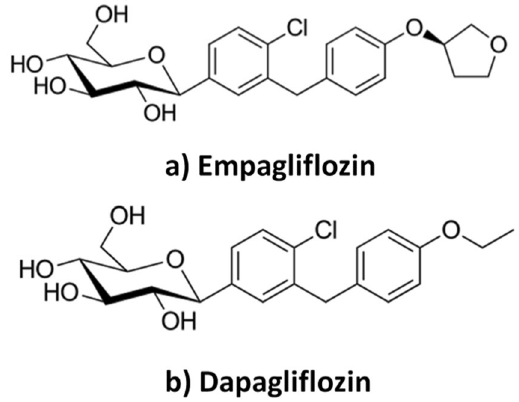
Figure 1. Chemical structures of empagliflozin ( a ) and the internal standard, dapagliflozin ( b